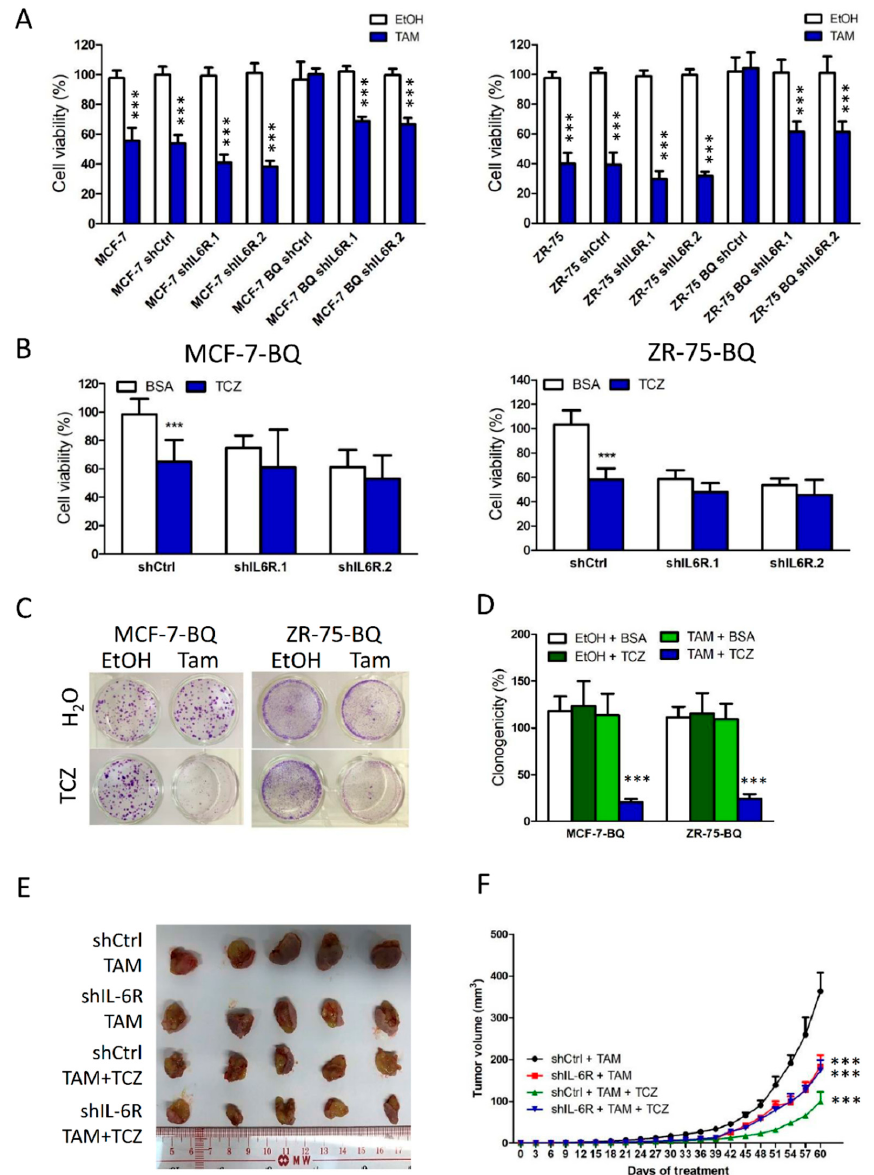
Figure 5. Targeting IL-6R could reverse tamoxifen (TAM) resistance in BQ overexpressing ER+ breast cancer. ( A ) Knockdown of IL-6R could enhance the efficacy of TAM in control cells and reverse TAM resistance in BQ overexpressing cells. Cell lines with stable IL-6R knockdown were used. The cells were treated with 5 µM of TAM for 96 h. MTT was used to determine cell viability. ( B ) Tocilizumab (TCZ) could reduce cell viability in BQ overexpressing cells in the presence of 5 µM of TAM. The effect of TCZ on cell viability was compromised by IL-6R knockdown. Two-hundred-and-fifty ng/mL of TCZ or BSA was used. MTT assay was performed after 96 h of the treatment. ( C ) TCZ could reverse TAM resistance in BQ-overexpressing cells. The cells were treated with 250 ng/mL of TCZ and 5 µM of TAM for 2 weeks. Clonogenic assay was performed. ( D ) Statistical analysis of ( C ). ( E ) TCZ could reduce TAM resistant in vivo. TAM-resistance cell lines LCC2 shCtrl and LCC2 shIL-6R (shIL-6R.1) were used for xenograft establishment. The mice were randomized into different groups. The mice received 0.5 mg of TAM and 2 mg/Kg of TCZ through subcutaneous injection. The mice were treated twice per week for 8 weeks. ( F ) The graph showed the volume change of tumors during the treatment period. Results were shown as mean ± SD from at least three independent experiments. Students’ t test was used to determine the statistical significance between treatment and control groups. *** represents p < 0.001.